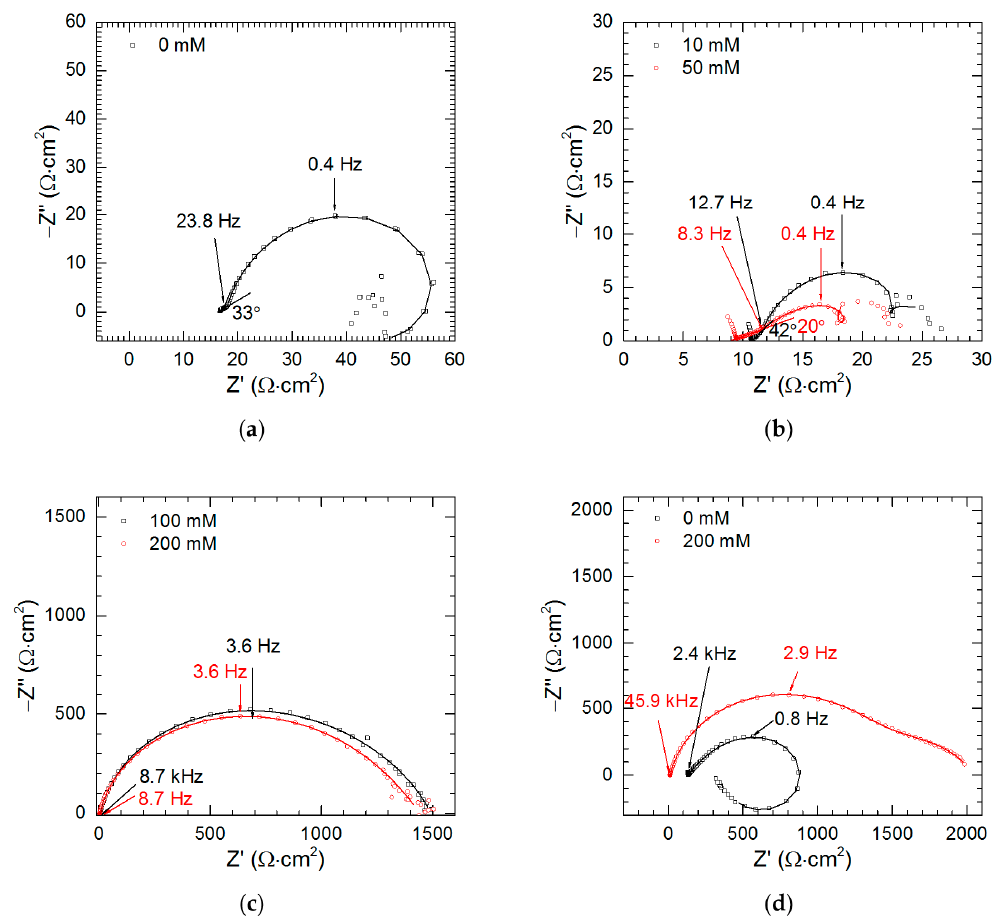
Figure 10. Impedance spectra of intermetallic Al 2 Cu as a function of initial concentration of Na 3 VO 4 in the solutions: ( a ) 0 mM, pH = 1.3, t = 576 min; ( b ) 10 and 50 mM, pH = 1.3, t = 576 min; ( c ) 100 and 200 mM, pH = 1.3, t = 576 min; ( d ) 0 and 200 mM, pH = 2.5, t = 159 min; T = 303 K, continuous lines indicate fitted parts of the spectra.